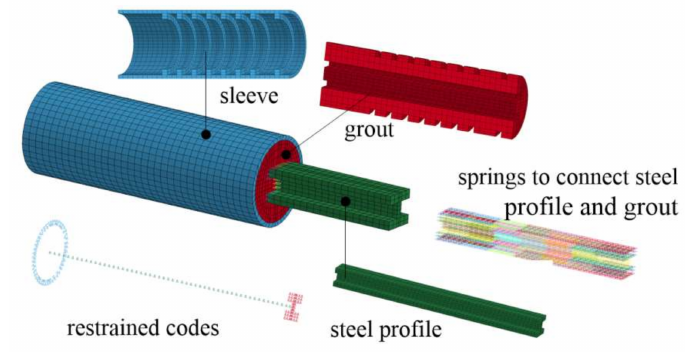
Figure 16. FEM model for Specimen